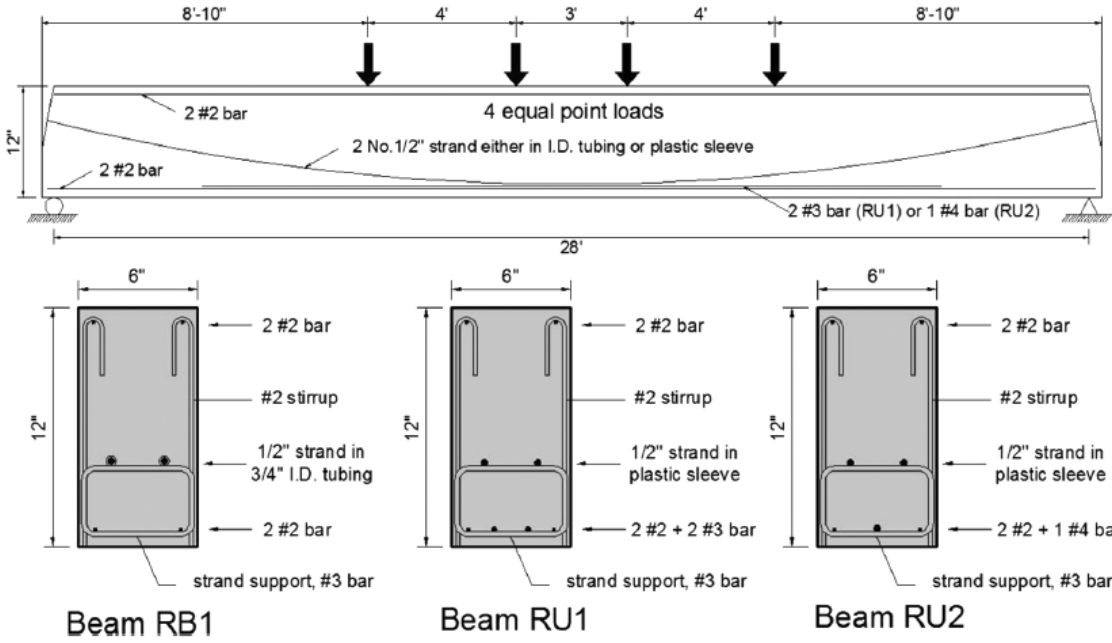
Fig. 1. Post-Tensioned beams conducted by Mattock et al. [4]